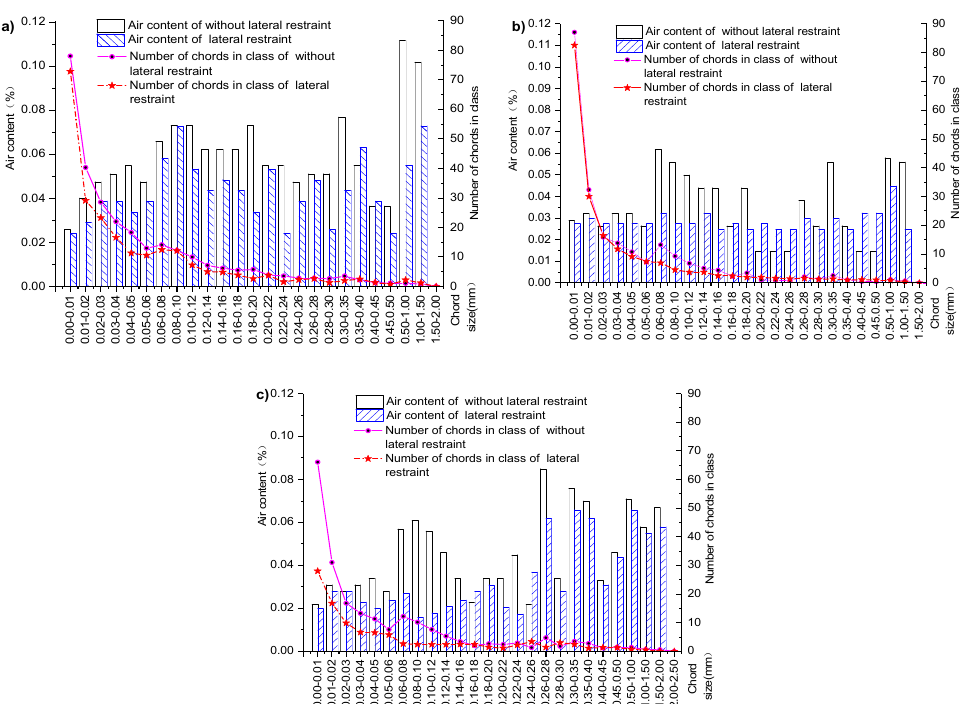
Figure 9. Effects of lateral restraint conditions on core concrete pore structures: ( a ) 4%; ( b ) 8%; ( c ) 12%.